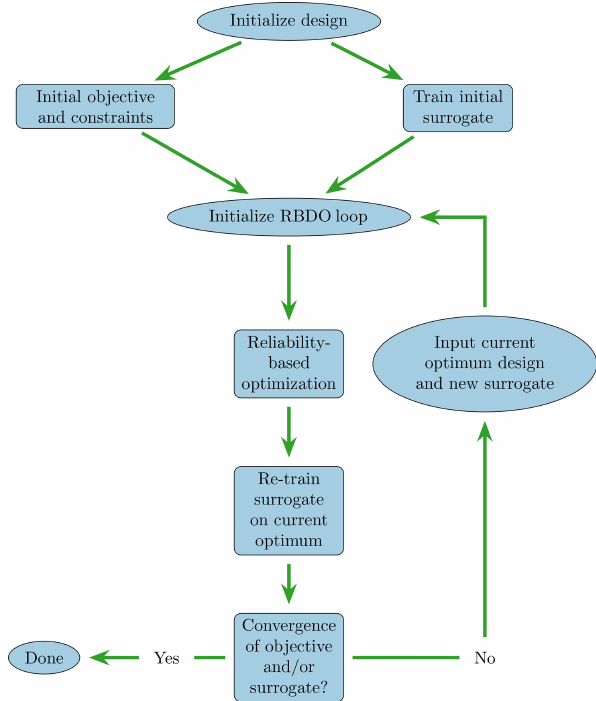
Figure 4. Flowchart representation of Algorithm 1.